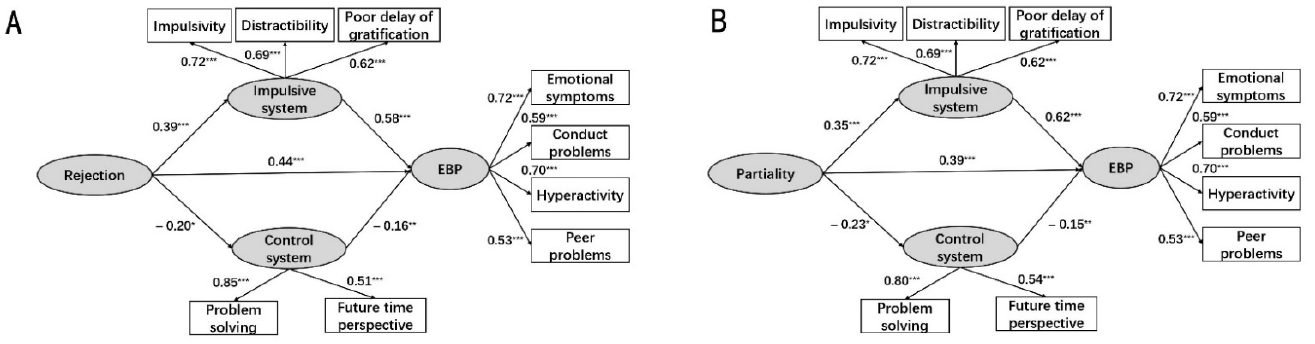
Figure 2. The mediating effects model for impulsive system and control system. ( A – E ) show the effects of rejection, par- tiality, severe punishment, emotional care and material care on EBP, respectively. Standardized path coefficients ( β ) are presented. Note: *: p < 0.05; **: p < 0.01; ***: p < 0.001. 4. Discussion This study investigated the influence of caregivers’ parenting styles on the EBP of left-behind children in senior grades of primary schools and analyzed the mediating effect of self-control. The results showed that rejection, partiality, severe punishment, emotional care and material care in caregivers’ parenting styles were correlated with self-control and EBP. The mediating effect analysis further revealed that the protective and risk factors for caregivers’ parenting styles could not only directly affect the EBP of left-behind children, but also indirectly affect EBP through the mediating effect of the dual mode of self-control. 4.1. The Relationships among Caregivers’ Parenting Styles, Self-Control and EBP This study found that material care and emotional care were positively correlated with the control system, but negatively correlated with the impulsive system and EBP. Rejection, partiality and severe punishment were negatively correlated with the control system, but positively correlated with the impulsive system as well as EBP, which was consistent with previous results [37,60]. The first thing that parents of left-behind children should solve in a migrant work environment is the family economic situation, which has been found to be an important factor affecting the social adaptation of left-behind children